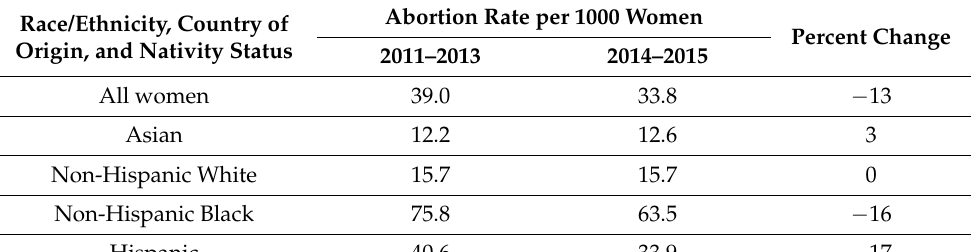
Table 3. Abortion rates and percentage change in rates between 2011–2013 and 2014–2015 among New York City women by race/ethnicity, country of origin, and nativity